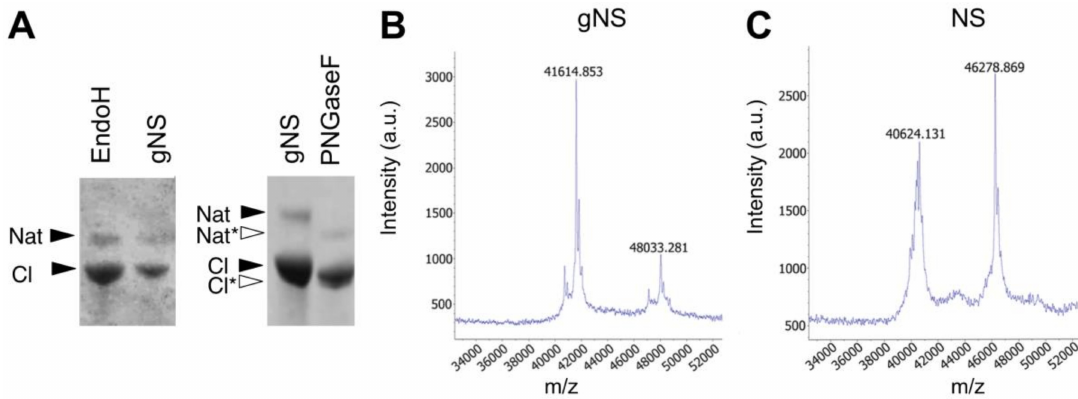
Figure 2. Assessment of N-glycosylation. ( A ) SDS-PAGE analysis of the enzymatic deglycosylation of gNS using EndoH or PNGaseF deglycosylases. All samples are a mixture of native and cleaved forms. Black and white arrows refer to lane 1 (gNS) and lane 2 (PNGaseF), respectively. ( B , C )